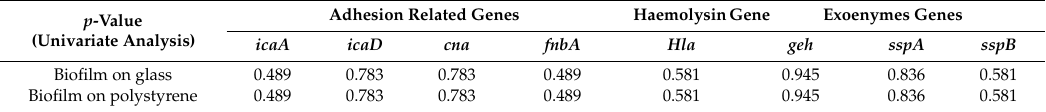
Table 6. Correlation between the ability to form a biofilm on polystyrene and glass material with